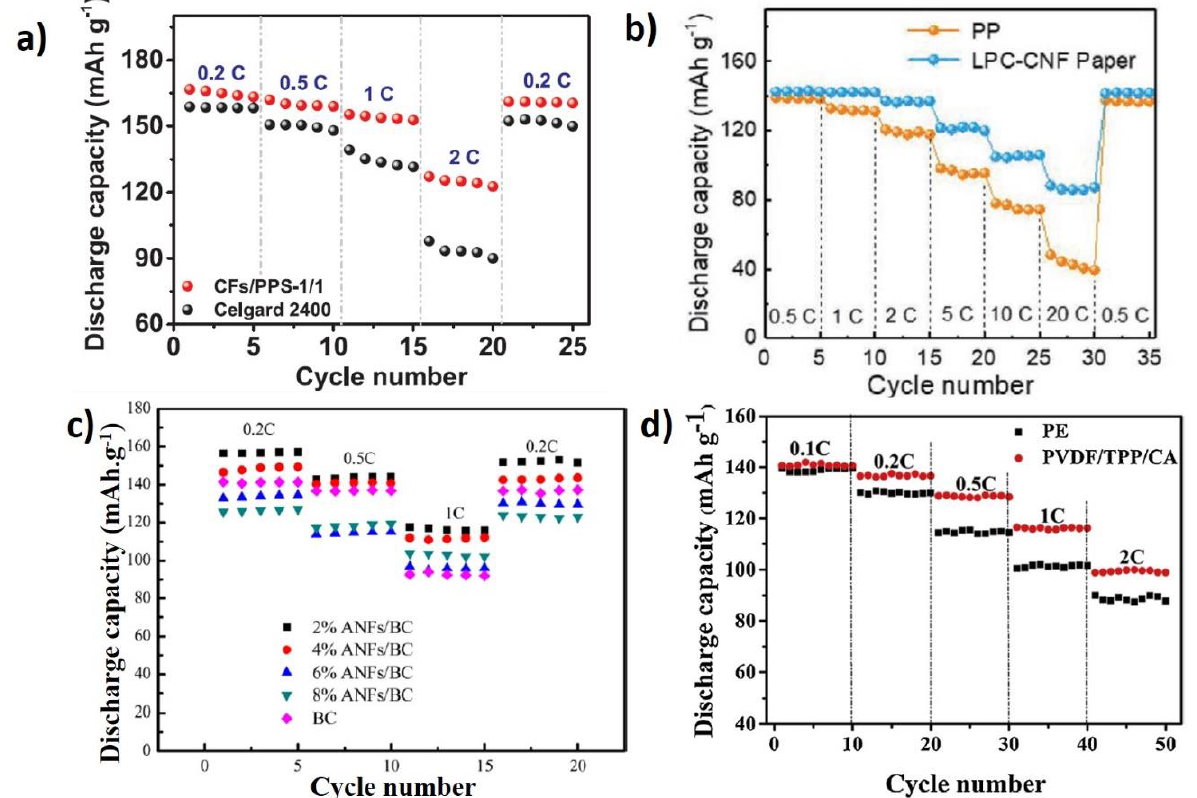
Figure 8. ( a ) Discharge C-rate capabilities of cells with Celgard 2400 separator and CFs/PPS-1/1 separator [212], ( b ) Rate capability of LFP half cells with PP and LPC-CNF paper separators at different current densities [231], ( c ) Rate capability of LFP half-cells with BC and ANFs/BC separators [200], and ( d ) Rate capabilities of LFP half cells using PE and PVDF/TPP/CA membranes [237]. Table 4. Recent advances in solid polymer electrolyte (SPE) technology for Li-ion battery applications.